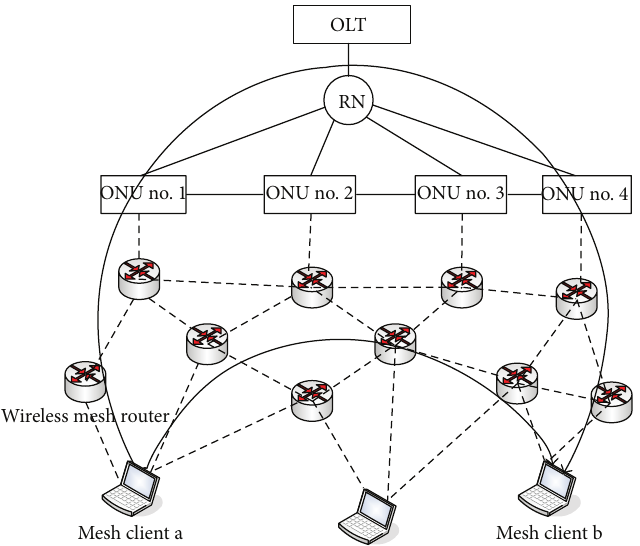
Figure 5: Architecture of Fi-Wi network with practical routing